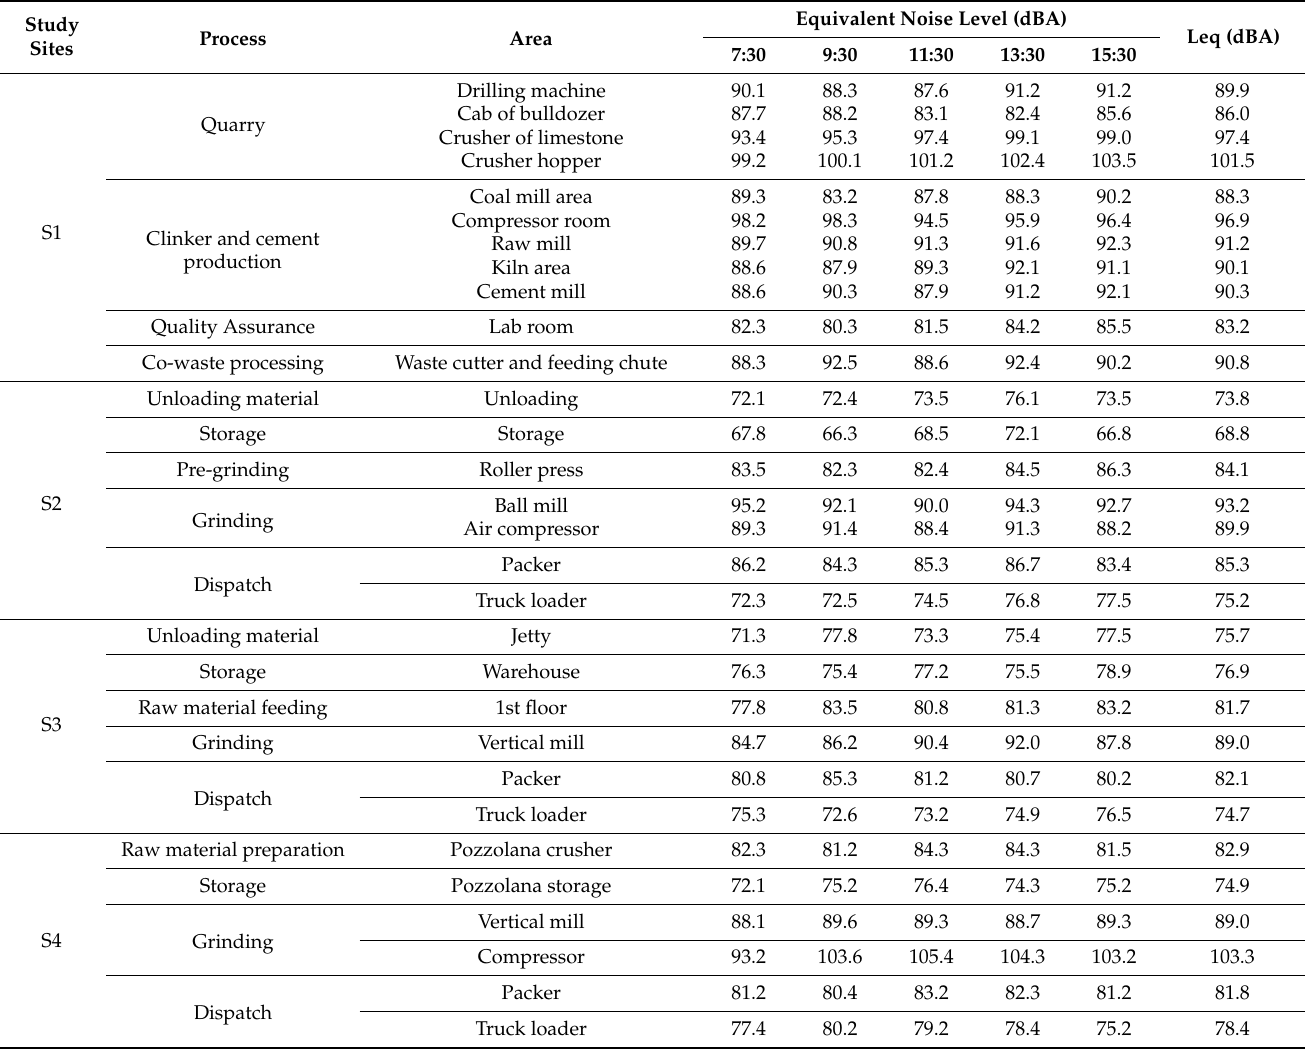
Table 2. The Equivalent Noise Level at the Cement